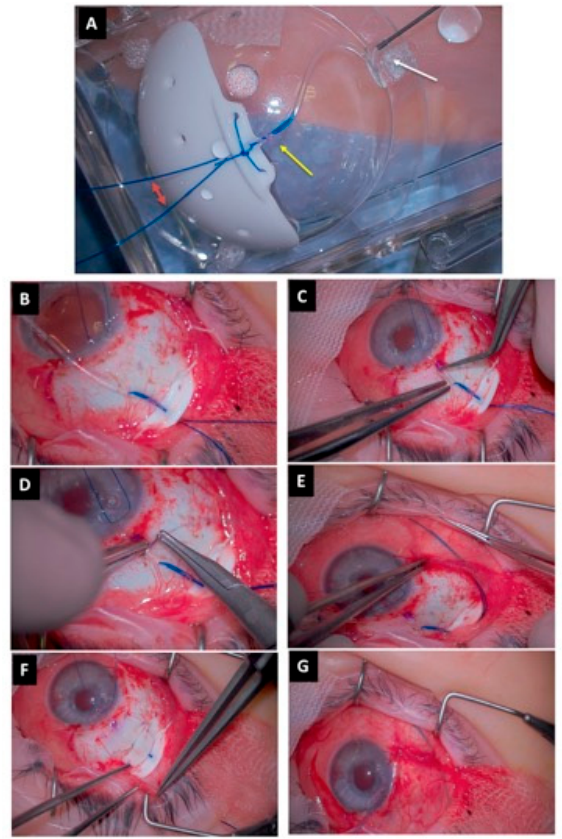
Figure 2. Surgical phases. ( A ): Long tube (Baerveldt) preparation. Two Prolene sutures (4-0 and 6-0, respectively) are positioned inside the tube (double-headed red arrow) and tightened through a Vicryl 7-0 (yellow arrow). The water-tight closure test is performed by injecting BSS into the tube and observing no fluid leakage on the plate of the device; ( B ): Baerveldt device positioned into the superotemporal quadrant and fixed at 10.0 mm from the limbus. The wings are positioned under the superior and lateral rectus muscles; ( C ): introduction of the tube into the anterior chamber after its trimming; ( D ): three fenestrations of the tube are performed in order to avoid postoperative IOP spikes; ( E ): both Prolene, 4-0 and 6-0, sutures are gently positioned under the conjunctiva reaching the inferotemporal quadrant; ( F ): the human scleral patch is used to cover the tube; ( G ): conjunctival suture using 7-0 Vicryl.